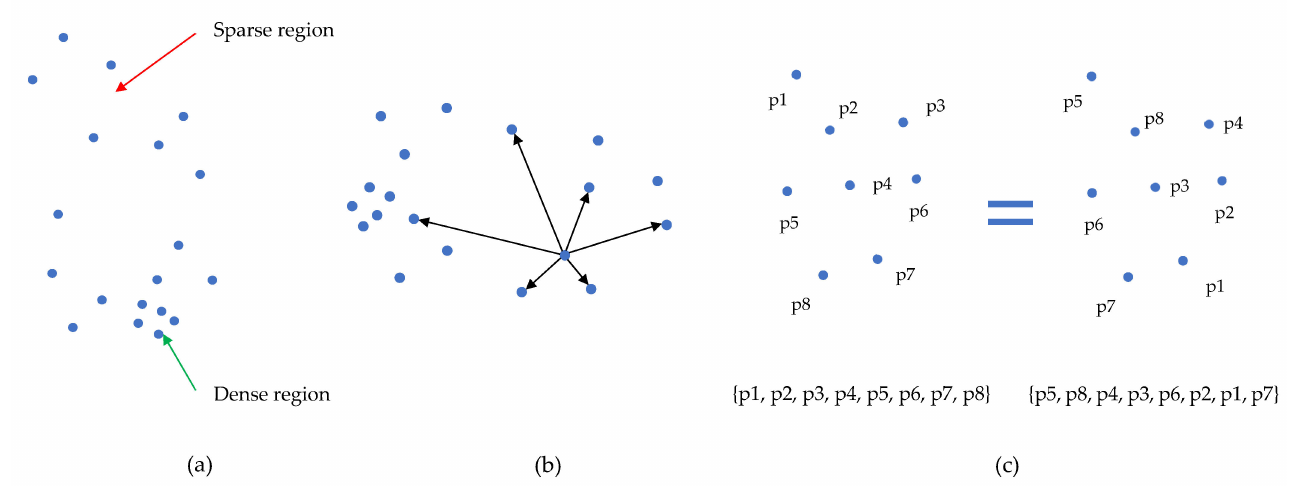
Figure 1. Challenges related to 3D point cloud processing. ( a ) Irregular: with dense and sparse regions. ( b ) Unstructured/no grid: each point is independent and the distance between adjacent points is not fixed. ( c ) Unordered: as a set, point clouds are permutation invariant. Unstructured. Unlike images, point clouds in their raw form are not placed on a regular grid. Each point is scanned independently, and its distance to adjacent points is not always fixed, as shown in Figure 1b, which makes their spatial structuration complex. In analogy to images where pixels are represented on a two-dimensional grid, and the space between two adjacent pixels is always fixed, the point cloud is sometimes transformed into voxels to facilitate processing